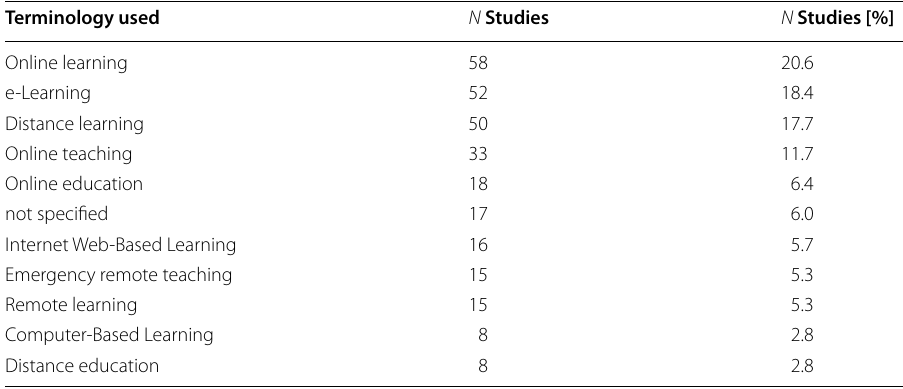
Table 6 Top 10 used terms for online learning during the pandemic Terminology